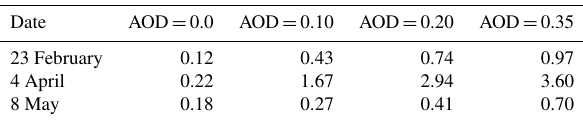
Table 4. sd_medians (ppm) for three different AODs in each simu- lated